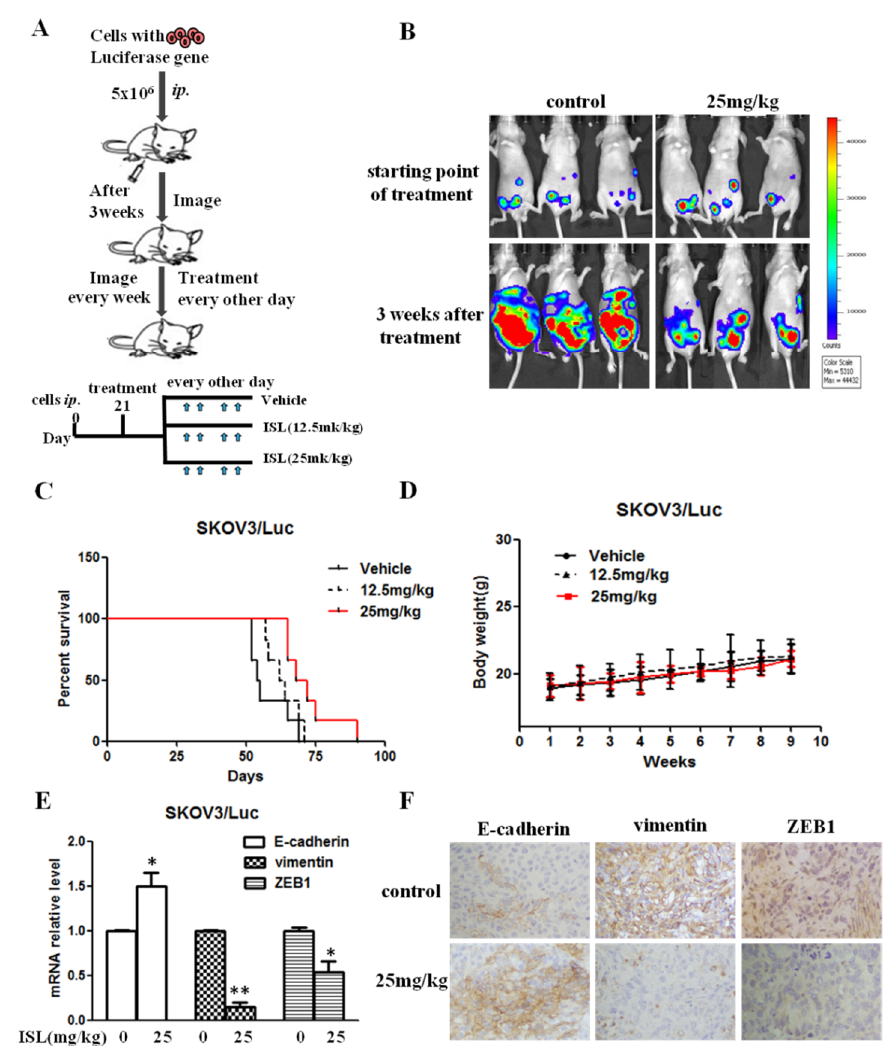
Figure 4. ISL blocked intraperitoneal xenograft development and prolonged the survival of ovary- tumor-bearing mice. ( A ) Flowchart of therapy scheme. ( B ) Luciferase-containing SKOV3 cells (5 × 10 6 cells/mouse) were injected intraperitoneally into nude mice for 3 weeks, followed by administration of 12.5 or 25 mg/kg of ISL. Tumors were imaged in the Xenogen system. ( C ) Kaplan–Meier